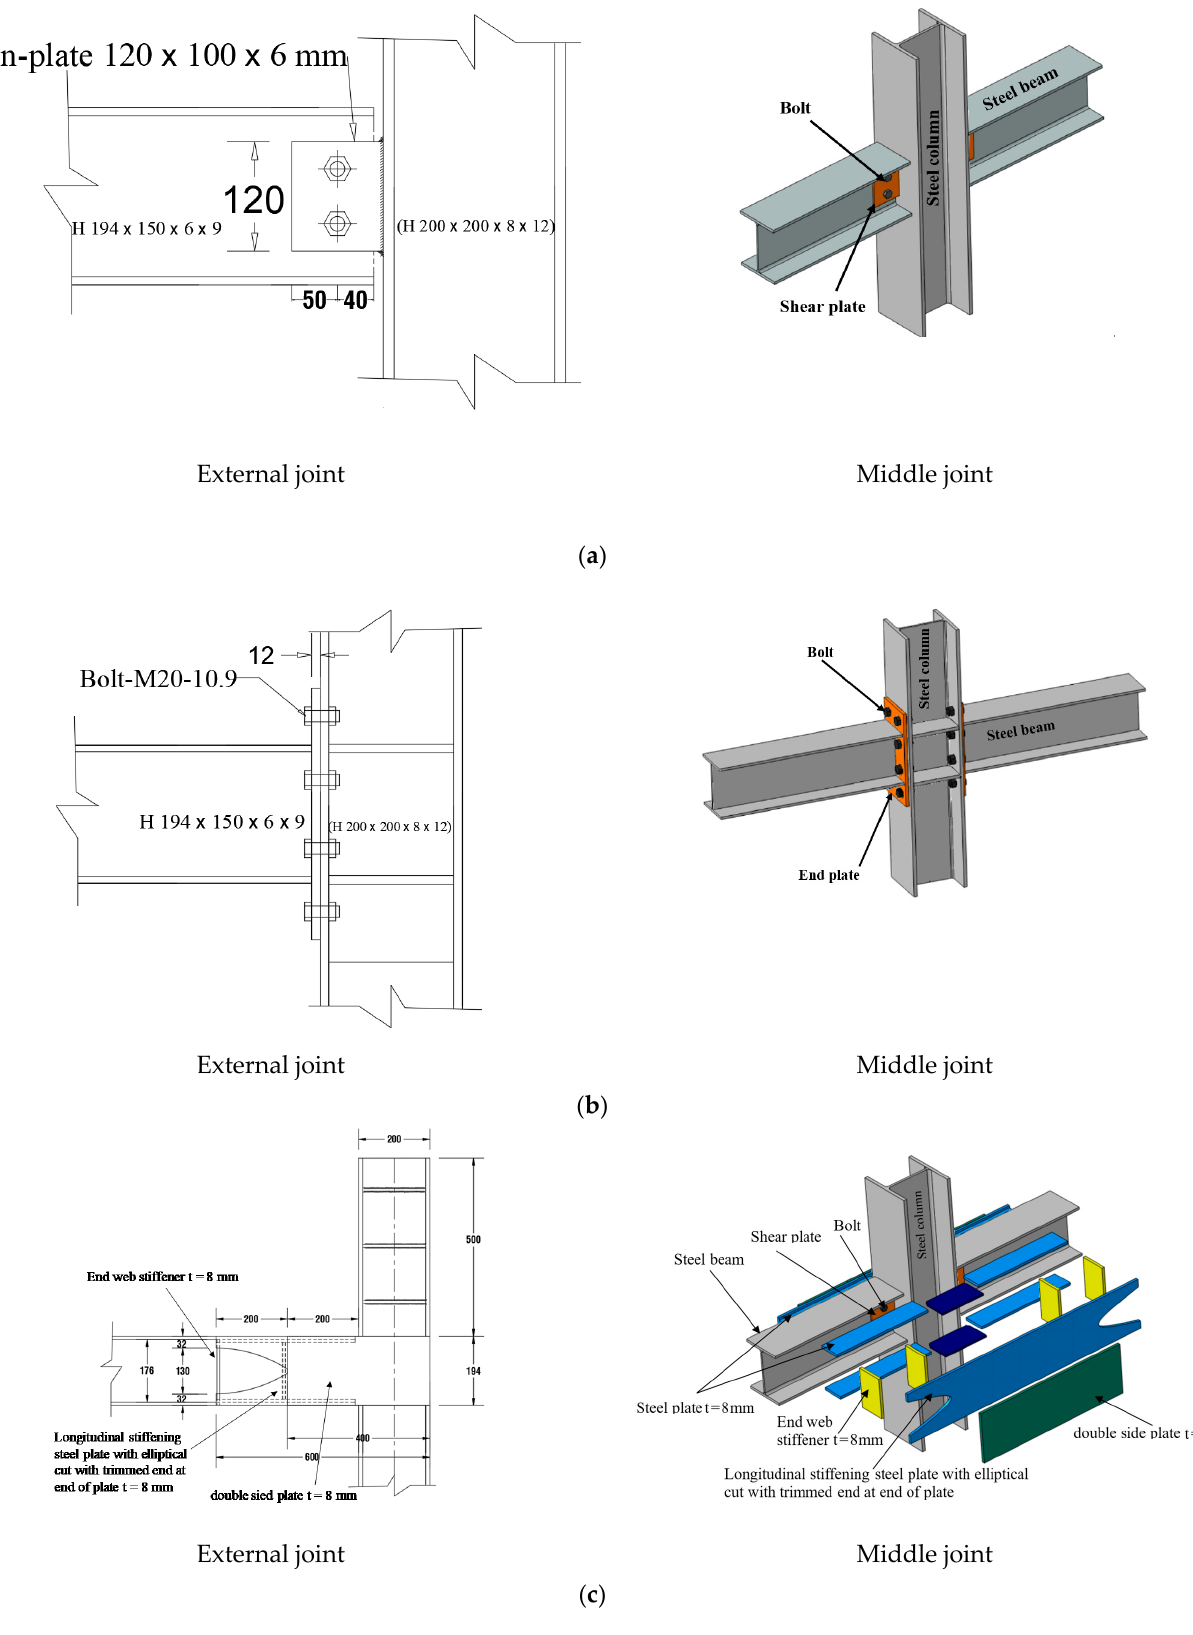
Figure 2. Details of external and middle steel beam–column joints: ( a ) Shear (simple) joint (J-S-C); ( b ) Details of IMF specimen (J-M-C); ( c ) Details of strengthened specimen (J-S-S-EX) [29].